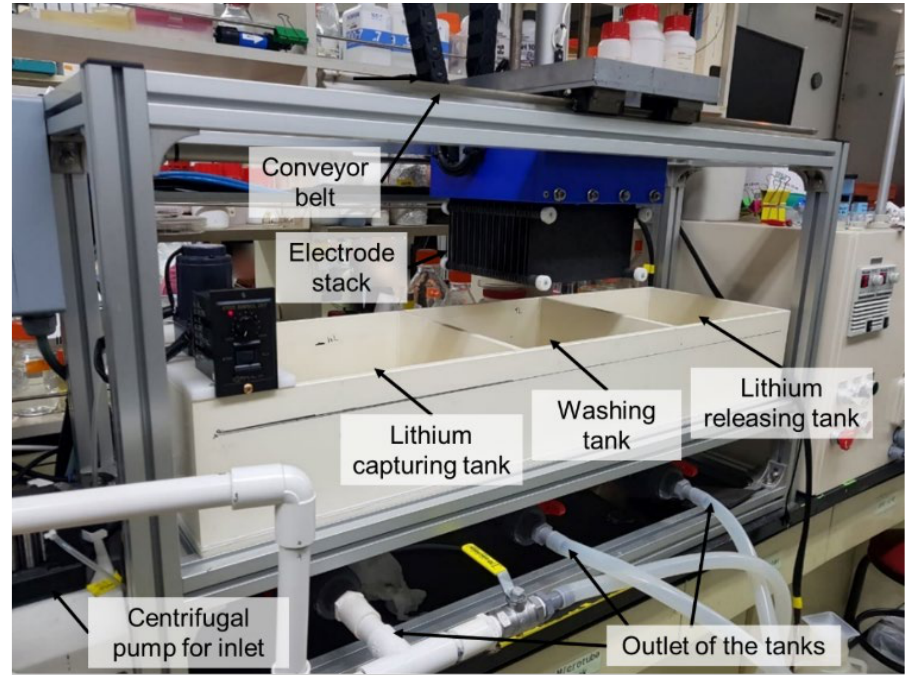
Figure 3. A portion of the pilot-scale ELR system: primary recovery process using λ -MnO 2 / Ag electrode stack.